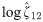
Network-wide oscillations can enhance or suppress the predicted levels of spike synchrony.(A) Dependence of logζ^12 on the difference in preferred phases between two neurons, as computed using models with and without an oscillatory factor. Purple and cyan arrows indicate two different Δ(Φpref)s. (B) Bootstrap-generated distribution of logζ^12 values under the null hypothesis of logζ
12 = 0. Arrowhead shows the value of logζ^12 computed by the simplified model. Thus, a significantly larger number of synchronous spikes is observed than predicted by the model lacking an oscillatory factor (log(ζ^12)=0.057±0.013, p value = 0.0025). (C) Including an oscillatory factor in the model yields an accurate prediction of the observed number of synchronous spikes (log(ζ^12)=−0.006±0.014, p value = 0.6775). (D, E) Same as (B,C) for different preferred phases that lead to significantly lower synchrony than predicted when an oscillatory factor is not included in the model (D: log(ζ^12)=−0.082±0.013, p value = 0.0025; E: log(ζ^12)=−0.009±0.015, p value = 0.2700). (F) Dependence of the power on number of trials and ζ. The mean firing rate is 25 Hz. The red and green lines indicate choices of ζ and N for which the power equals 0.8, based on simulation and theory respectively. (G) Same as (F), but the mean firing rate is 10 Hz.